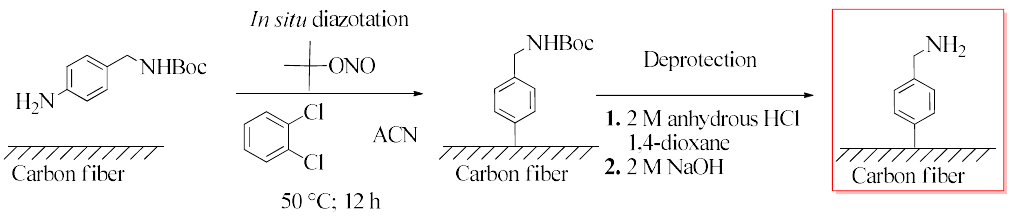
Figure 2. Reaction scheme for grafting 4-(aminomethyl)benzene functions onto the carbon fiber surface. Abbreviations: Boc— tert -butyloxycarbonyl protecting group; and ACN—acetonitrile.